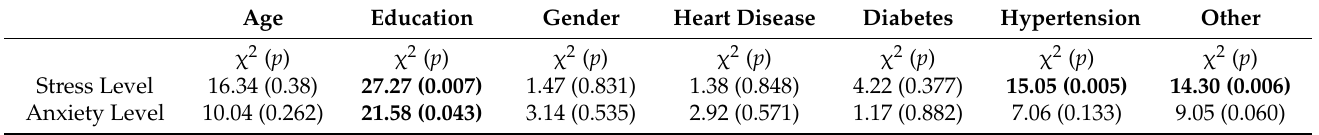
Table 8. Stress and Anxiety Levels in Relation to Gender, Age, Education, and Medical